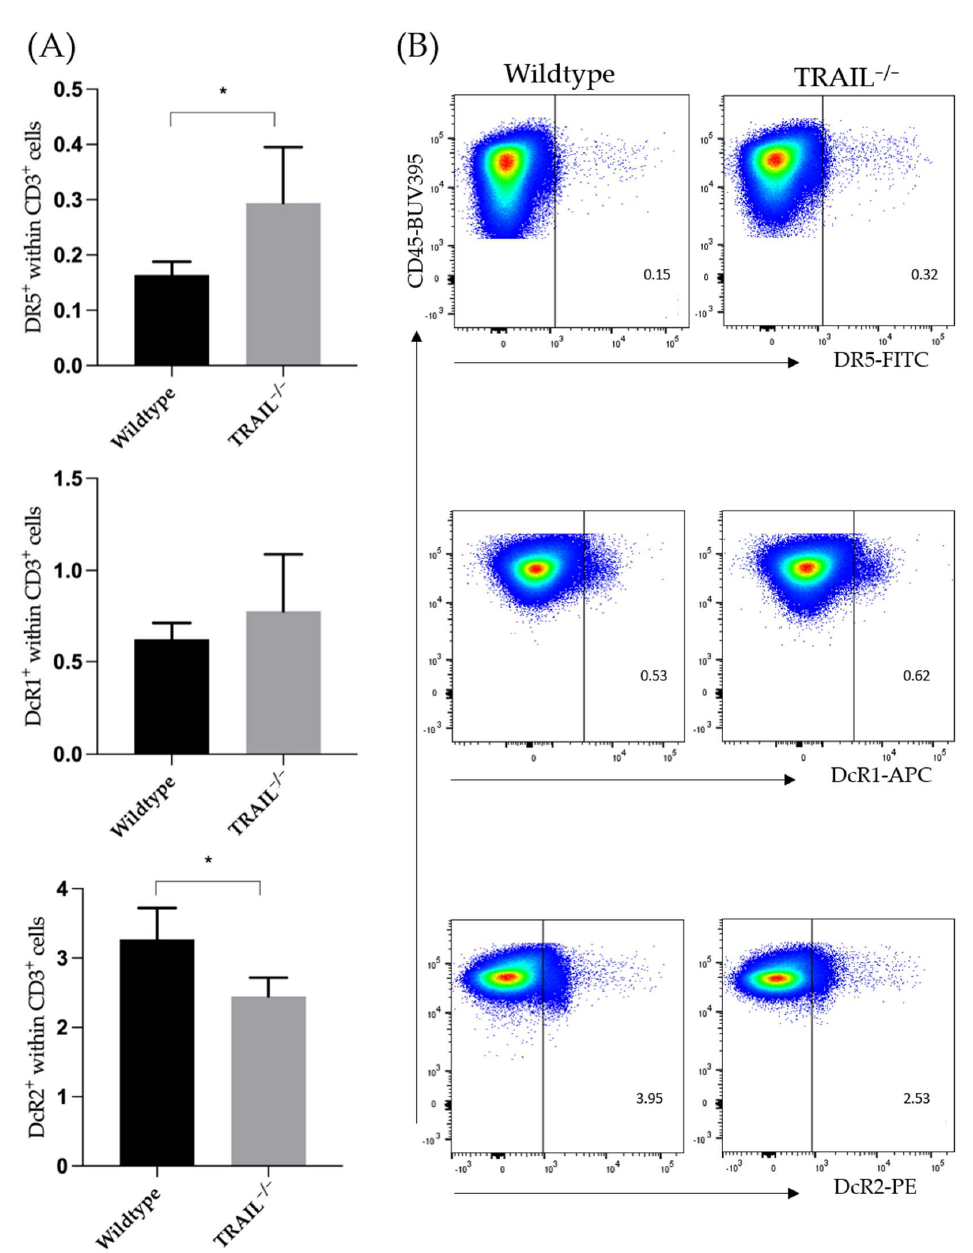
Figure 5. ( A ) Bar graph compares frequencies ± SEM of DR5, DcR1, and DcR2 expression on the CD3 + lymphocytes in the spleen of TRAIL −/− mice versus wildtype C57BL/6 mice ( n = 5). ( B ) Exem- the CD3 + lymphocytes in the spleen of TRAIL − / − mice versus wildtype C57BL/6 mice ( n = 5). ( B ) Exemplary dot plots illustrate DR5, DcR1, and DcR2 expression ( t -test, n = 5 per group, * p <